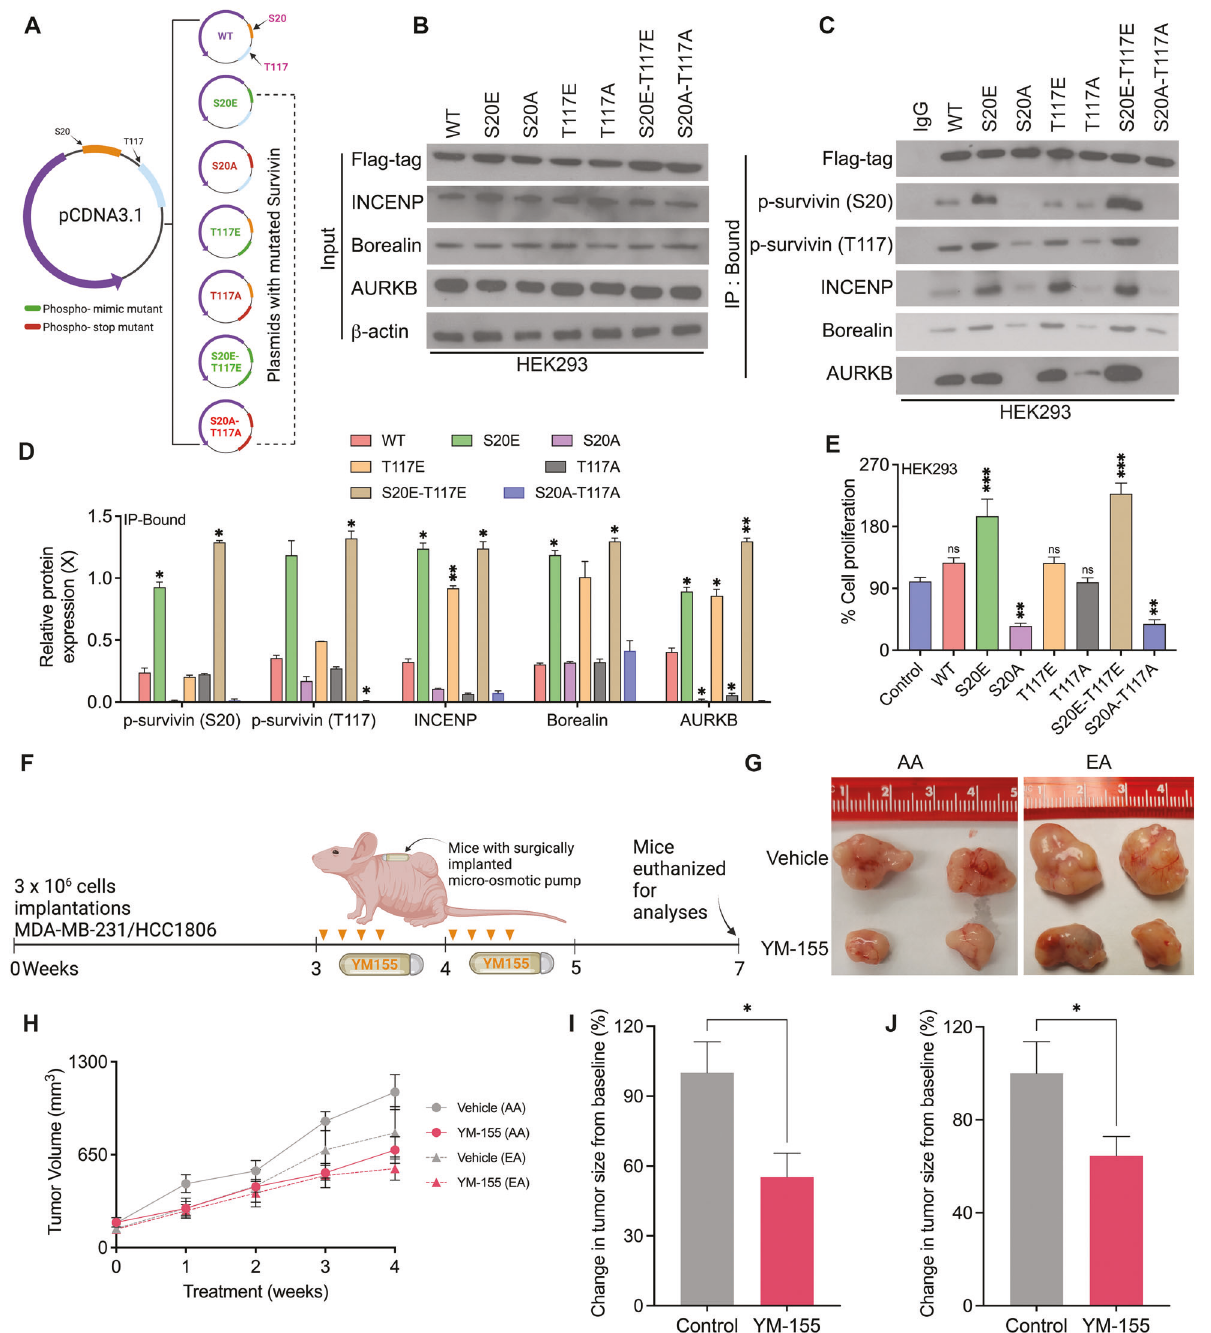
Fig. 7 CPC complex formation is highest in S20-T117 double phospho-mimic survivin mutants. A Schematic representation of survivin- mutant plasmids. B – D Immunoblots ( B , C ) showing the levels of CPC proteins in input ( B ) and IP-bound ( C ) samples from cells expressing various survivin-WT and mutant plasmids, and their respective quanti fi cation ( D ). E Bar graphs showing the percentage of cell proliferation in control cells and in cells expressing survivin-WT and mutant plasmids. F Schematic illustration of YM155 treatment schedule in mice bearing tumors and surgically implanted with osmotic pumps. G – J Representative tumor images ( G ), changes in tumor volume ( H ), and changes in tumor size ( I , J ) in mice bearing AA ( n = 12) and EA ( n = 12) TNBC xenografts. Bars represent mean ± SEM. Unpaired two-tailed Student ’ s t -test with Welch ’ s correction was used to determine statistical signi fi cance (* P < 0.05, ** P < 0.005, ns = non-signi fi that in contrast to the inhibition of survivin phosphorylation using phosphorylation at S20 and T117, respectively, reducing prolifera- volasertib and barasertib, inhibition of survivin at the transcrip- tion in AA TNBC cells. Additionally, AA TNBC cell lines showed tional level using YM155 is not suf fi cient to suppress tumor higher levels of p-survivin S20 and p-survivin T117 than EA TNBC growth in AAs with TNBC. Thus, targeting survivin phosphorylation cells. The higher phosphorylation of survivin at S20 and T117 in AA at S20 and T117 using volasertib and barasertib may serve as a TNBC cells is responsible for higher CPC complex formation and, viable treatment alternative for AA patients with TNBC. Studies to consequently, a higher proliferation rate. Our data also suggest